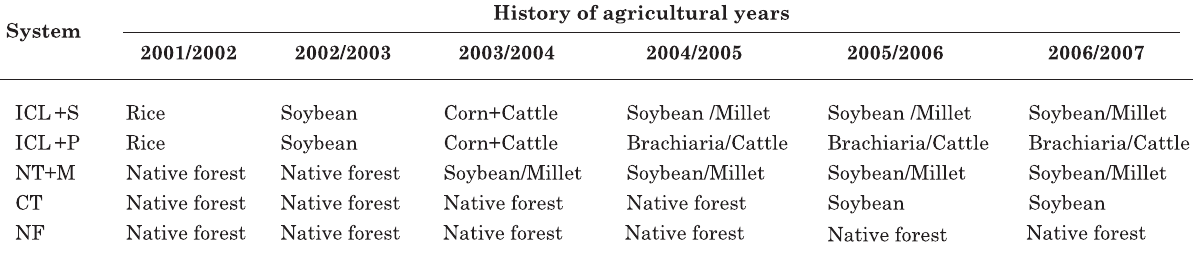
Table 1. History of different management